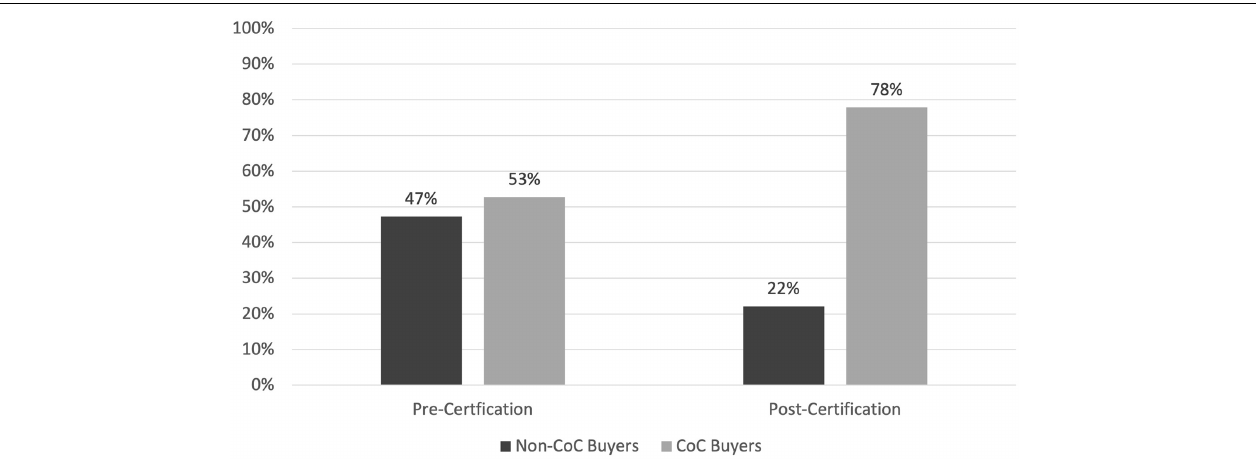
FIGURE 1 | Ex-vessel market share (lbs) of albacore purchased by first buyers who held MSC chain of custody certification for albacore in 2016, before and after initial MSC certification (PacFIN landings for United States west coast 2000-16; https://pacfin.psmfc.org/).